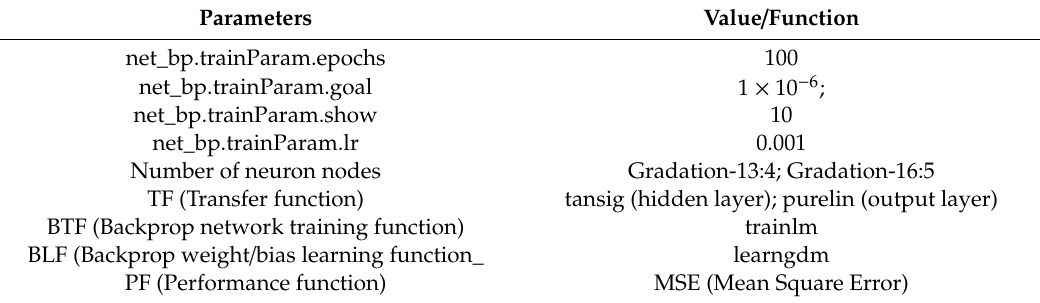
Table 8. Parameters needed in “newff” function .